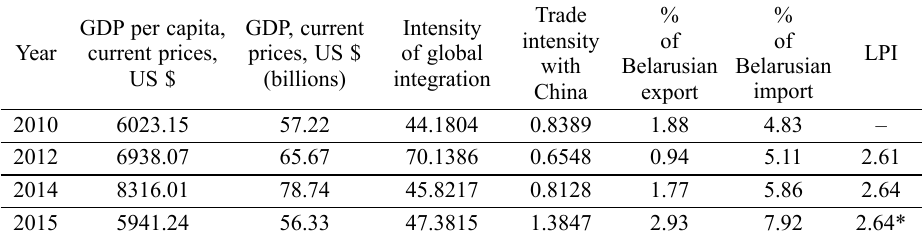
Table 5. Evaluation of the potential of Belarus as a participant of the NSR